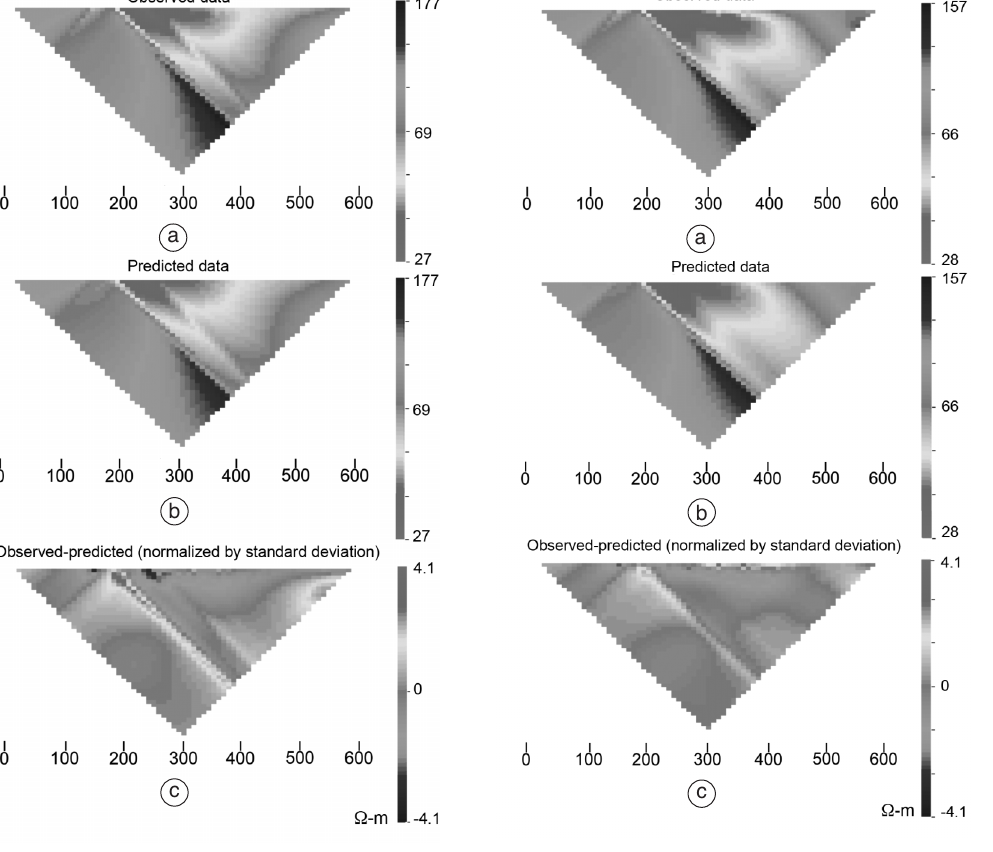
Fig. 13a-c. Result of geophysical inversion, pdL con- figuration, Model 2, Scenario 2, at 700 days: a) ob- served data; b) predicted data; c) difference between observed and predicted data.